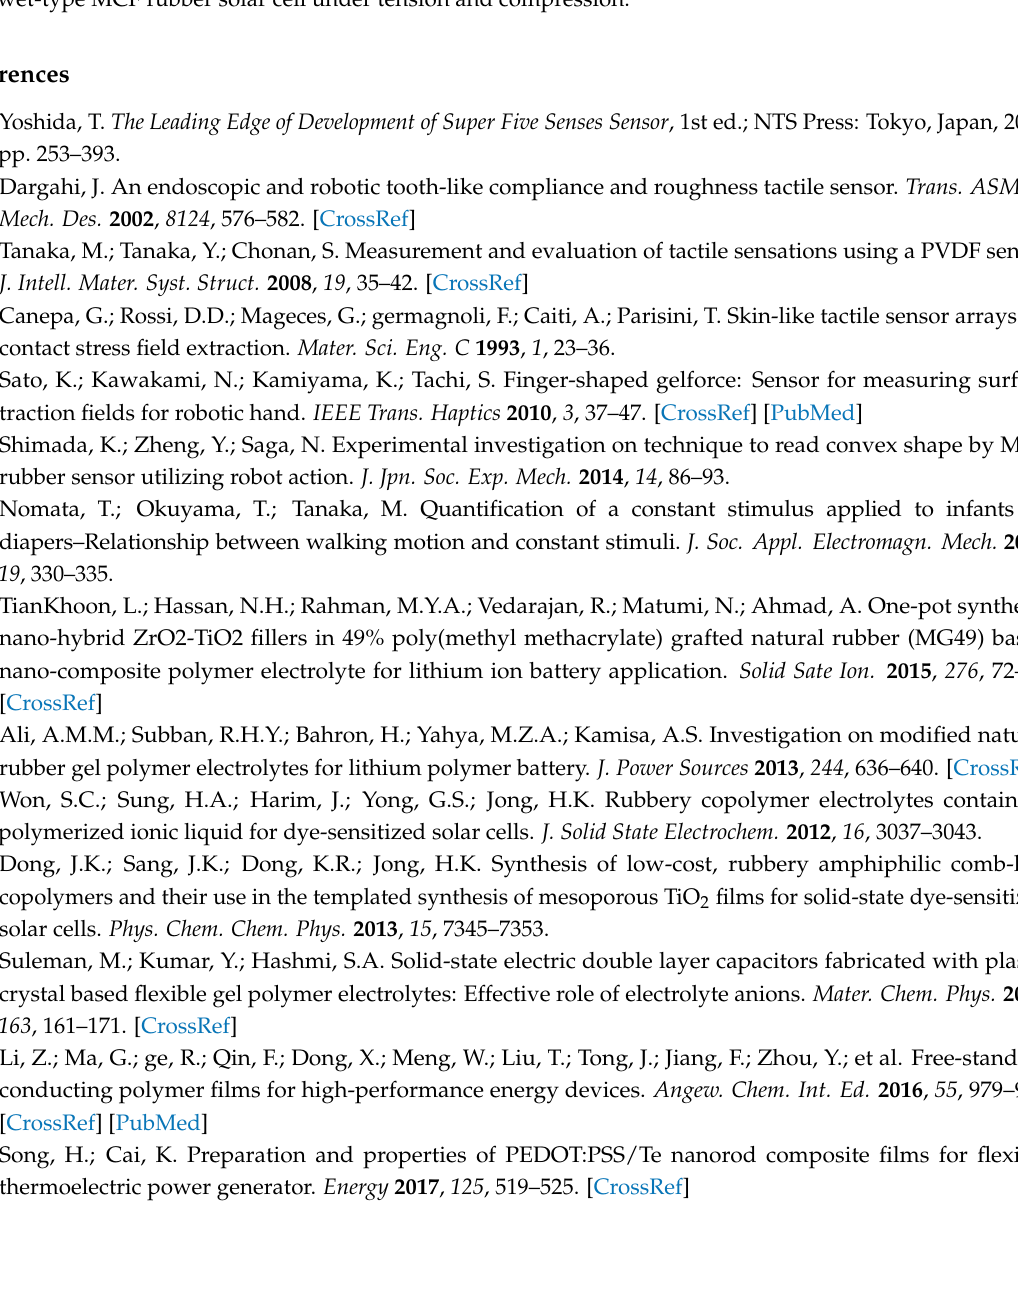
Figure A5. Schematic diagram of experimental apparatus for measuring cyclic voltammogram of wet-type MCF rubber solar cell under tension and compression.